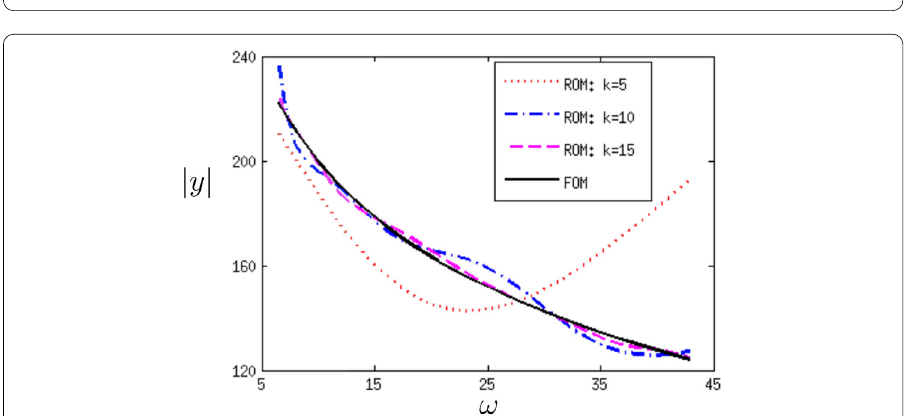
Fig. 2 The FRFs of Loewner ROMs and the FRF of the FOM at p = 268 . 3